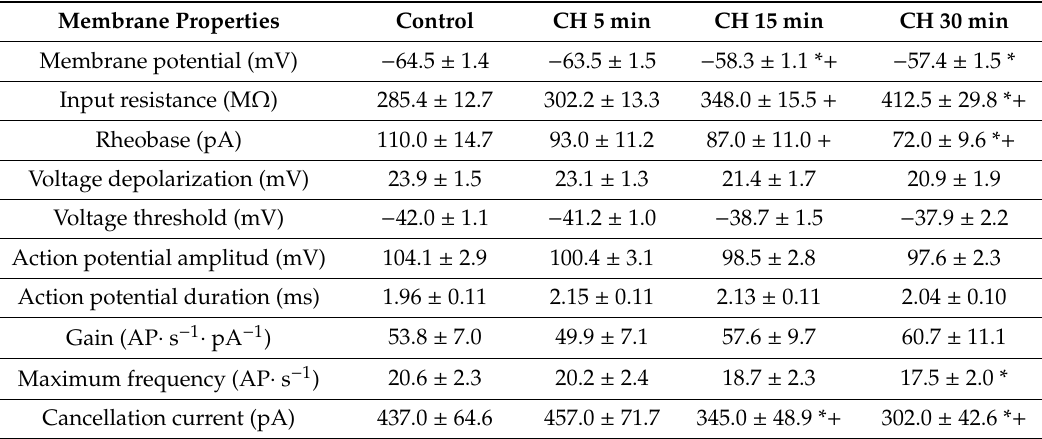
Table 2. E ff ects of cumene hydroperoxide (CH) on the electrophysiological properties on the pyramidal motor cortex neurons of young